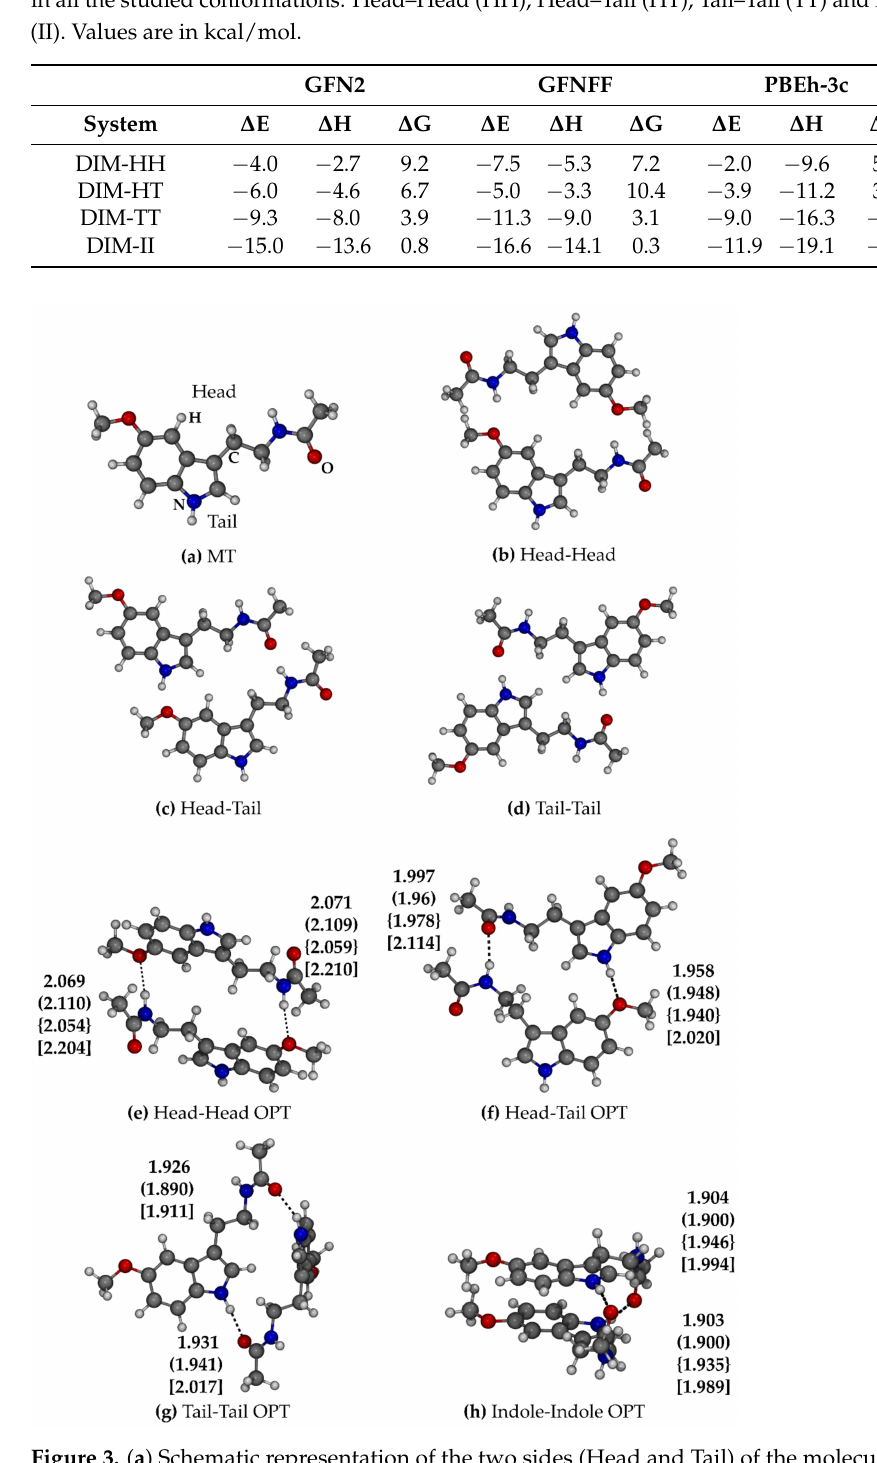
Figure 3. ( a ) Schematic representation of the two sides (Head and Tail) of the molecule with accep- tor/donor groups. ( b – d ) Starting structures of melatonin dimers. ( e – h ) Optimized (OPT) structures of melatonin dimers. Bond length notation: GFN2, (GFNFF), {B3LYP}, [PBEh-3c]. Bond distances are in Å. Atom colors: H white, C grey, N blue, O